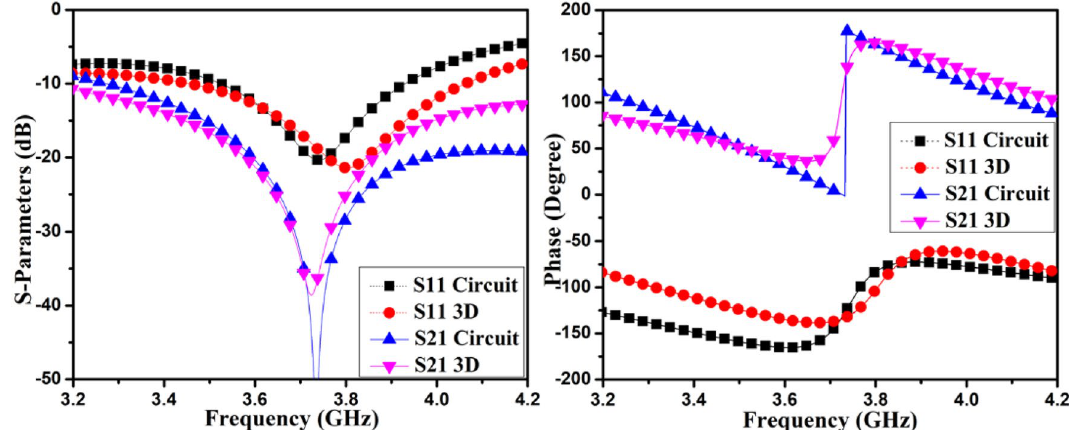
Figure 6. Phase plot and S-parameter simulated results of the 3D model and matching circuit of AntII.